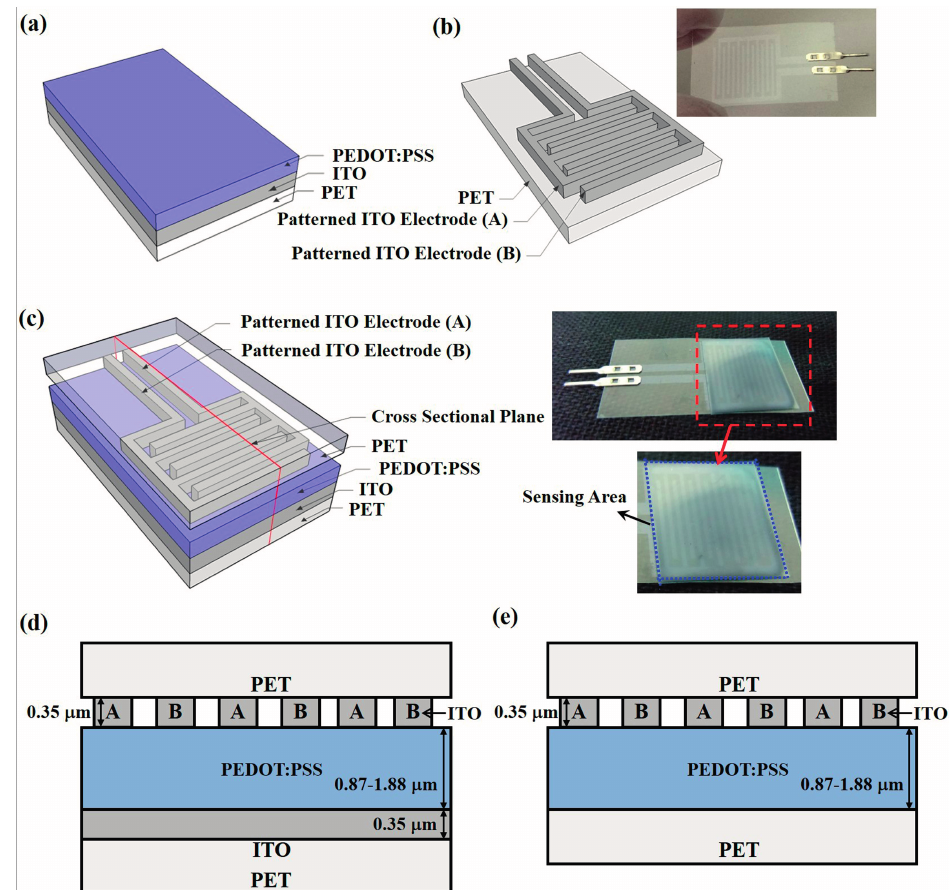
Figure 1. Schematic diagrams of the poly(3,4-ethylenedioxythiophene):polystyrene sulfonate (PEDOT:PSS) pressure sensors with inter-digitated electrode (IDE) structures for ( a ) part I; ( b ) part II; and ( c ) the final device with image picture, and the cross-sectional diagrams of the IDE pressure sensors ( d ) with and ( e ) without b-ITO